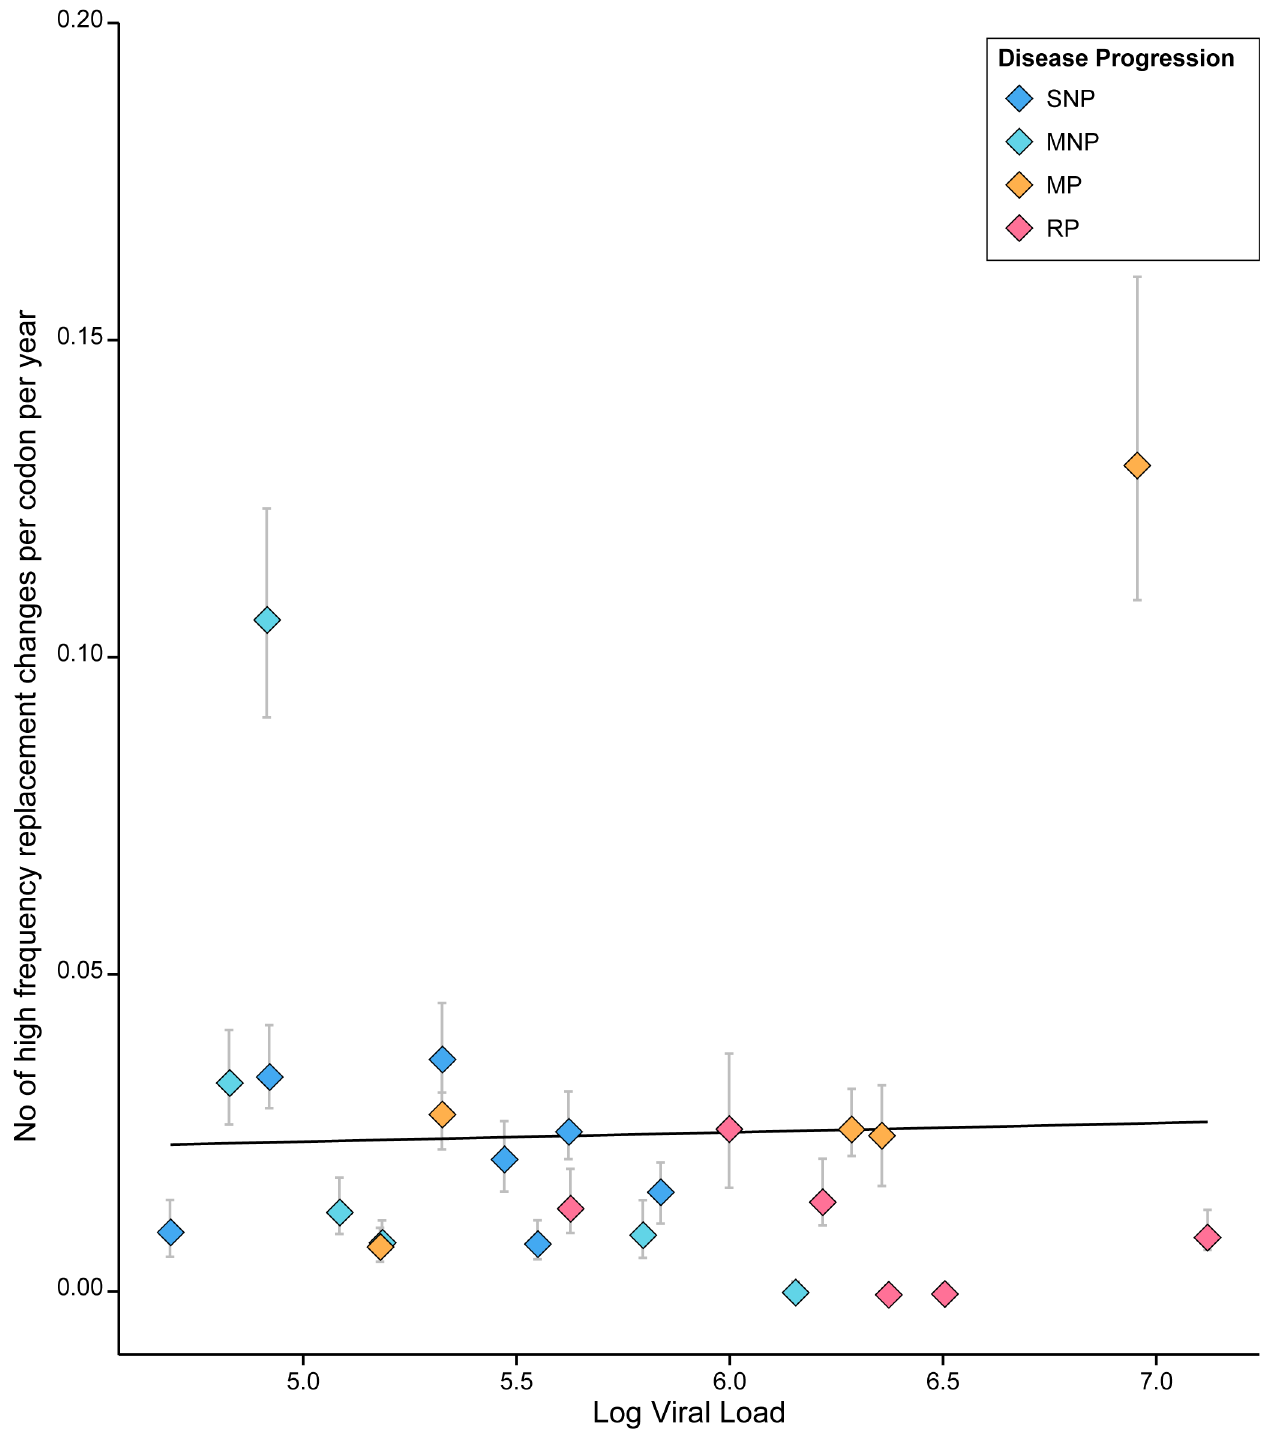
Fig 5. The number of high-frequency replacement polymorphisms (scaled by the number of codons in each alignment and the number of years of observation) is not correlated with viral population size (Spearman ’ s rank correlation; p > 0.05). If natural selection were weak compared to genetic drift then a negative correlation would be expected, due to an increased fixation of slightly deleterious mutations in populations of small size. The data points are labeled using the color scheme employed in Fig 2.